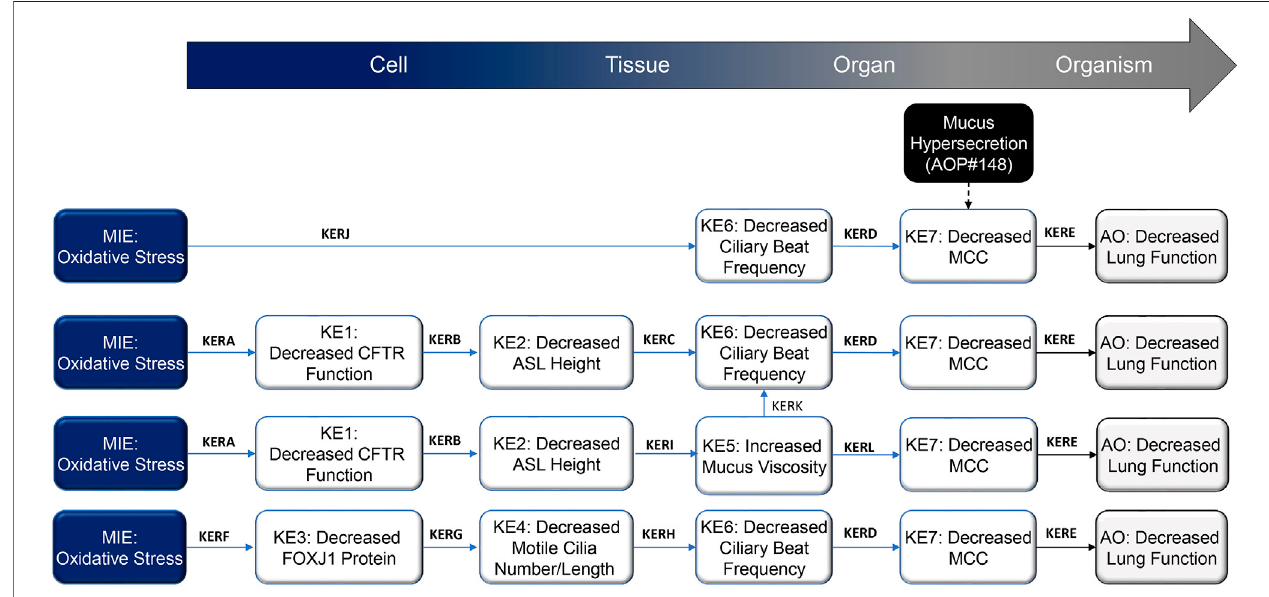
FIGURE1| Schematicrepresentationoftheproposeddecreasedlungfunctionadverseoutcomepathways(AOP),focusingonmechanismsthatresultinimpaired mucociliary clearance (MCC) following inhalation exposure. Abbreviations: AO, adverse outcome; ASL, airway surface liquid; CFTR, cystic fi brosis transmembrane regulator; FOXJ1, forkhead box protein J1; KE, key event; KER; key event relationship; MCC, mucociliary clearance; MIE, molecular initiating event.